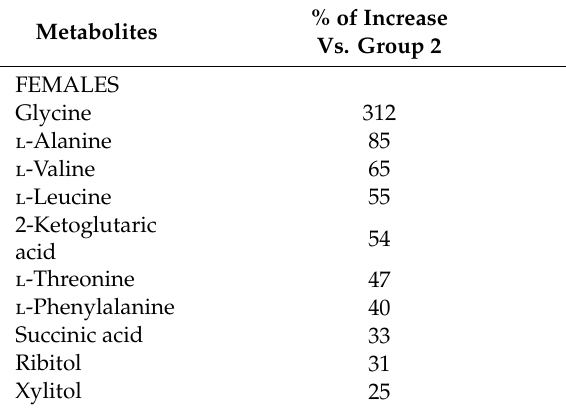
Table 3. Metabolites significantly increased in the Group 1 vs. Group